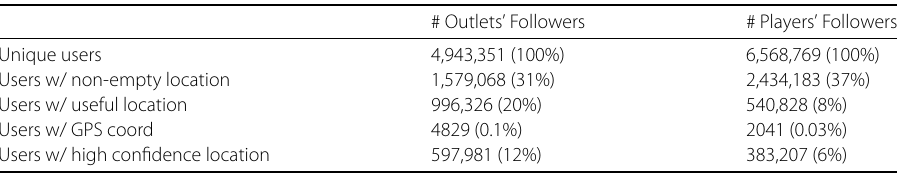
Table 1 Summary of news outlets and football players followers on Twitter # Outlets’ Followers # Players’